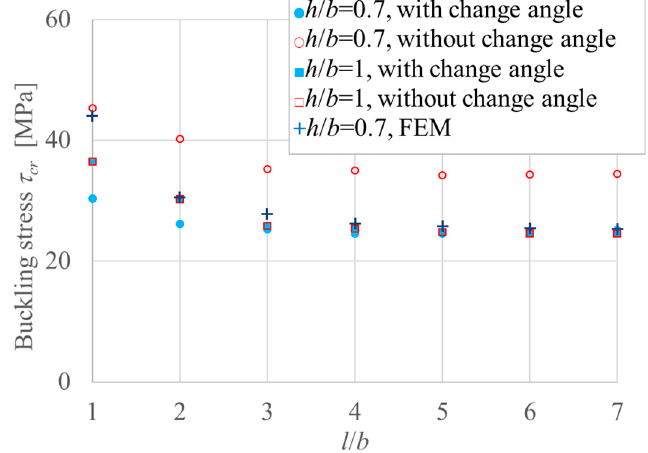
Figure 6. FE analysis of torsional buckling.